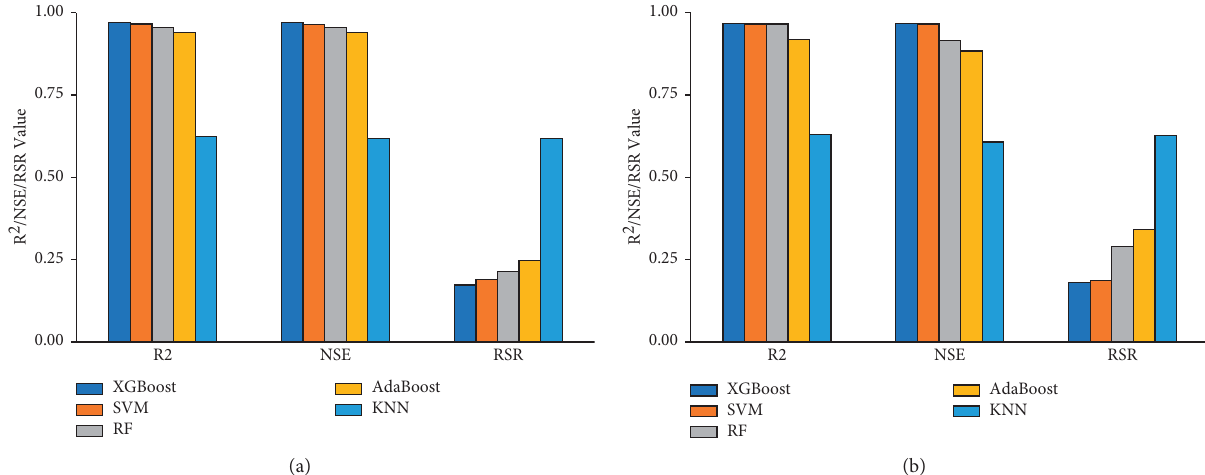
Figure 4: Comparison of R 2 , NSE, and RSR values from the XGBoost, SVM, RF, AdaBoost, and KNN models in (a) training; and (b) testing